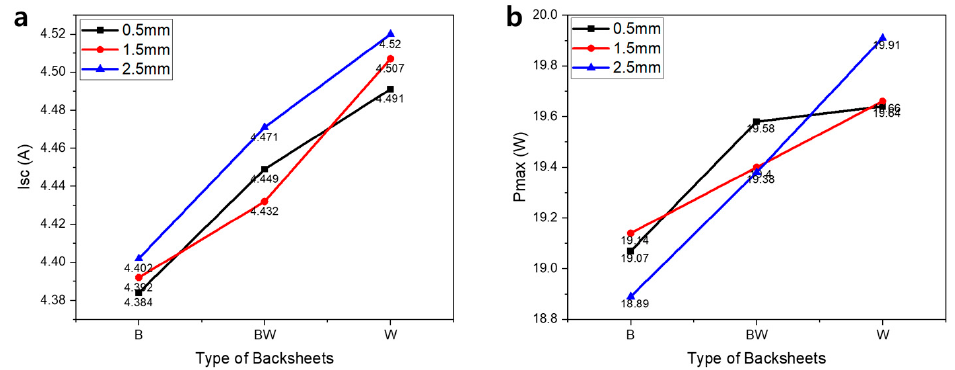
Figure 3. ( a ) The short-circuit current (I sc ) and ( b ) maximum power (P max ) of the MBB PV modules with white, black, and W-B hybrid backsheets and various cell spaces (0.5, 1.5, 2.5 mm) .